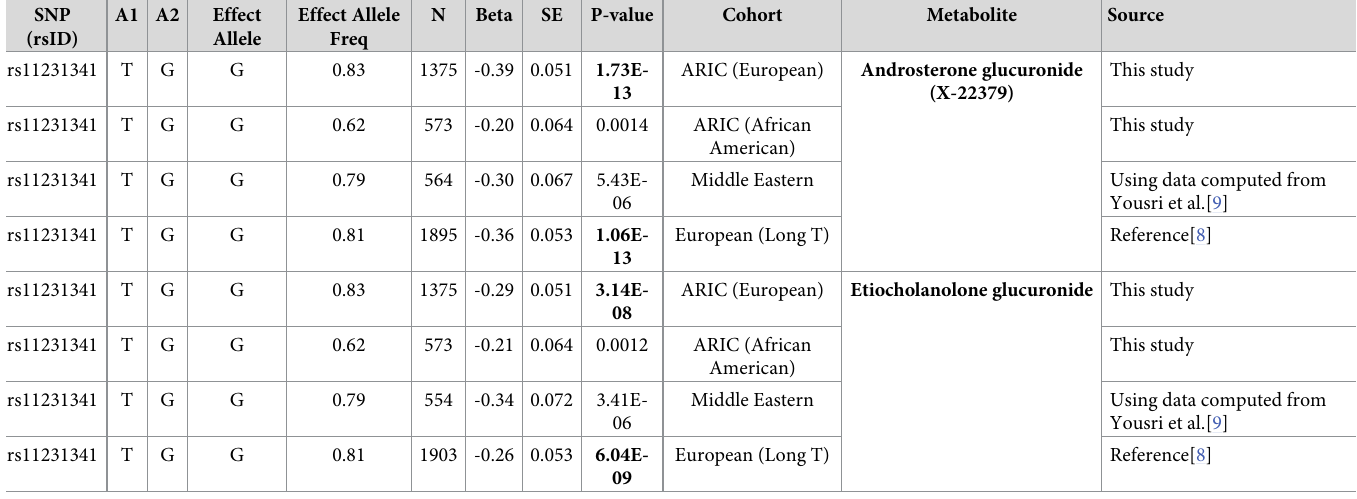
Table 1. Association of SLC22A24 p.Tyr501Ter (rs11231341, c.1503T > G) with two steroid conjugates in three cohorts. Association of SLC22A24 p.Tyr501Ter (rs11231341, c.1503T > G) with steroid glucuronide levels. Major G-allele (coding for SLC22A24 p.Tyr501Ter) is associated with lower steroid glucuronide levels. The data from ARIC cohort are available through the established database of Genotypes and Phenotypes (dbGaP) application procedure for the ARIC study (dbGaP Study Acces- sion: phs000280.v5.p1). SNP